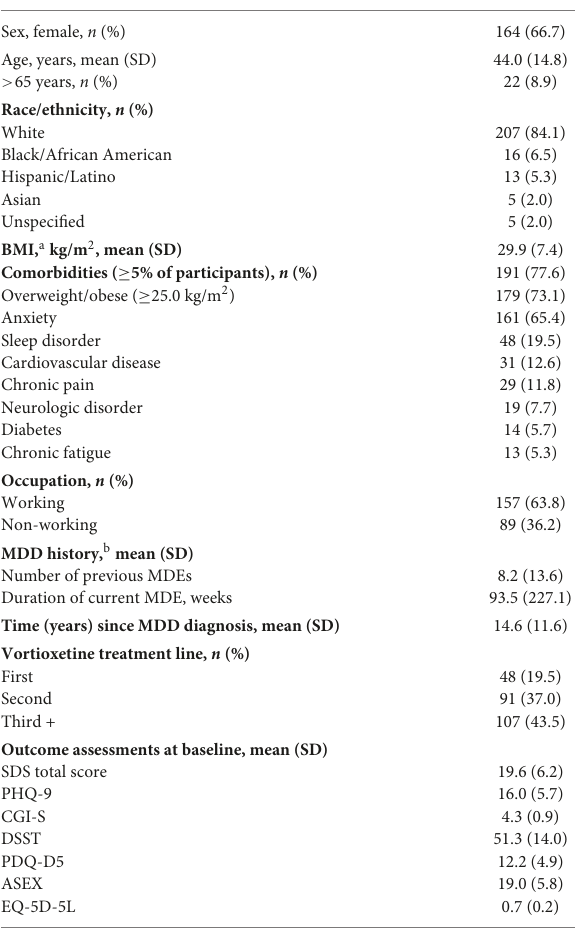
TABLE 1 Baseline characteristics and demographics of participants in the RELIEVE study United States